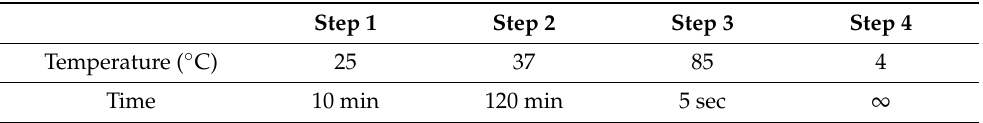
Table 2. Cycling parameters for Reverse